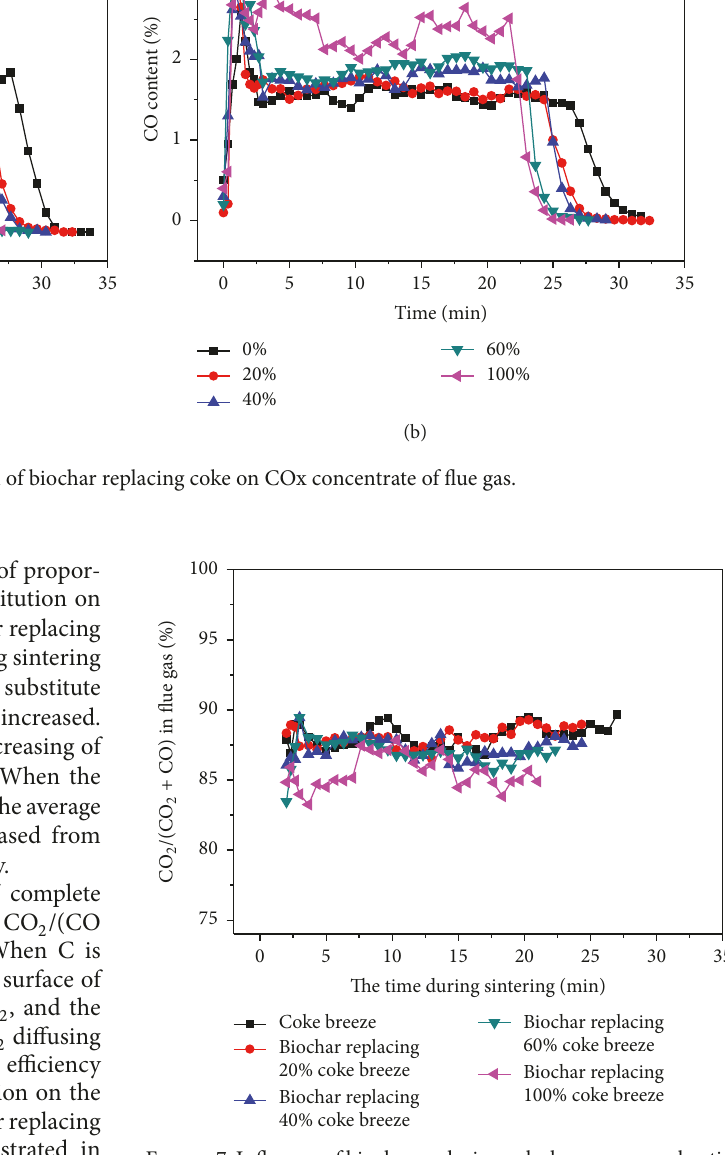
Figure 7: Influence of biochar replacing coke breeze on combustion